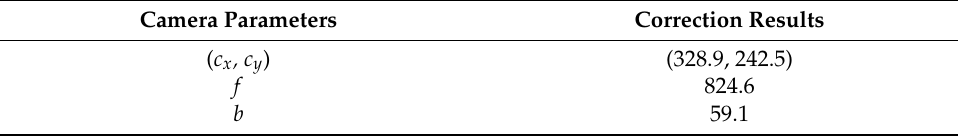
Table 2. The corrected results of camera